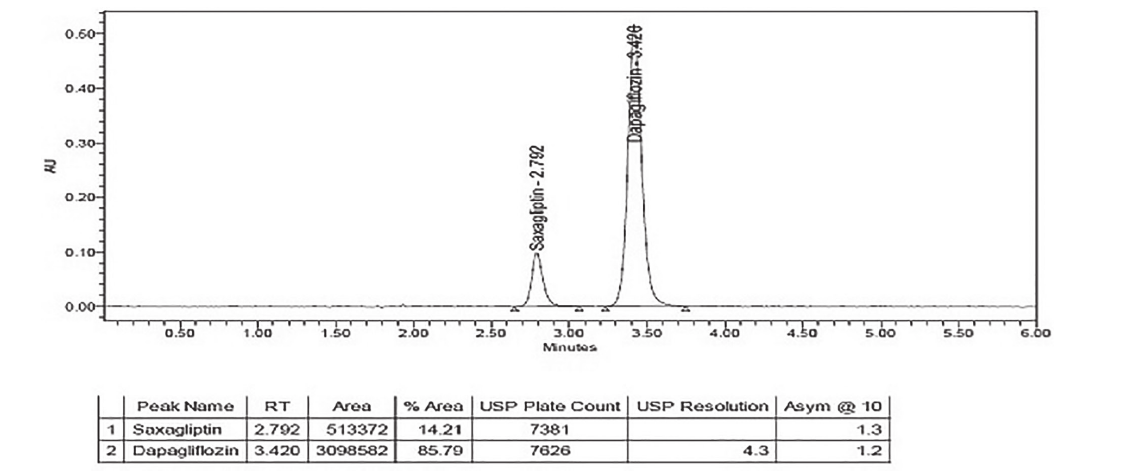
FIGURE 7 - Optimized RP-HPLC chromatogram for SAXA and DAPA at 210 TABLE III - ANOVA regression analysis for models and responses